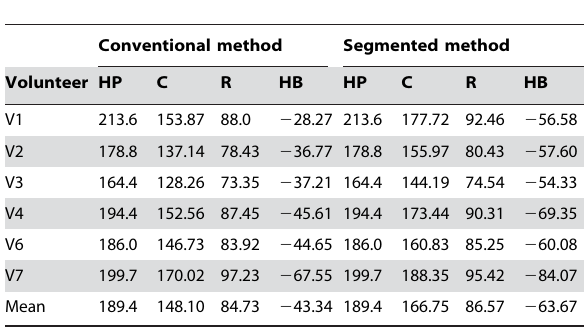
Table 6. Estimates of heat production, convective heat loss, radiant heat loss and heat balance using the conventional method and the segmented method when Ta is 20 u C.